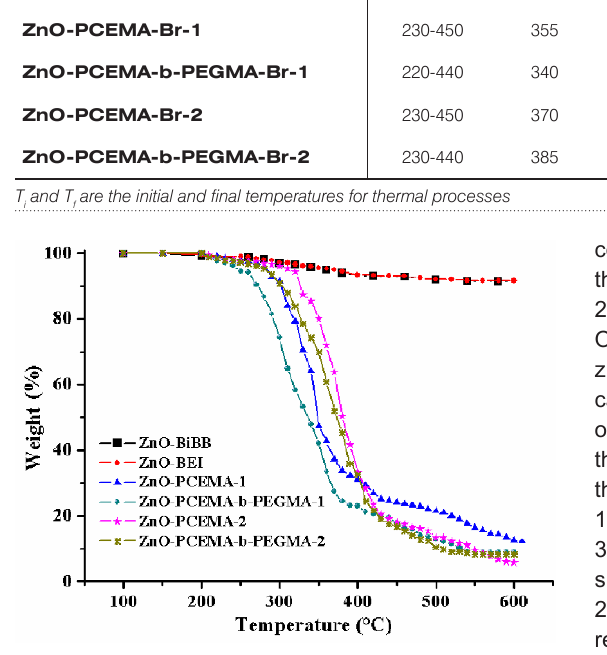
Figure 3. The TGA curves of raw ZnO nanoparticles, ZnO-BEI initiator, ZnO-PCEMA-1,2 macroinitiators and ZnO- PCEMA- b -PEGMA-1,2 block